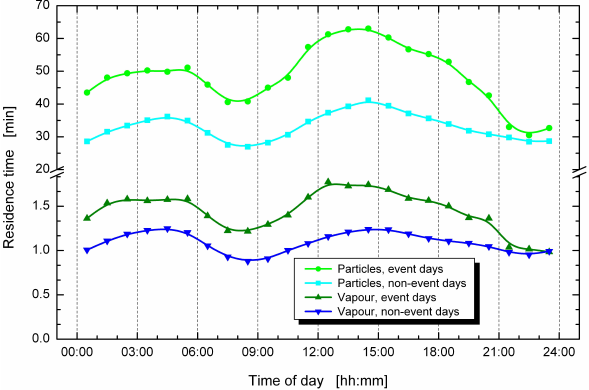
Fig. 9. Diurnal variation of the mean atmospheric residence time for H 2 SO 4 vapour and particles with a diameter of 6nm, averaged by the time of day separately for the days with new particle formation event and without new particle formation